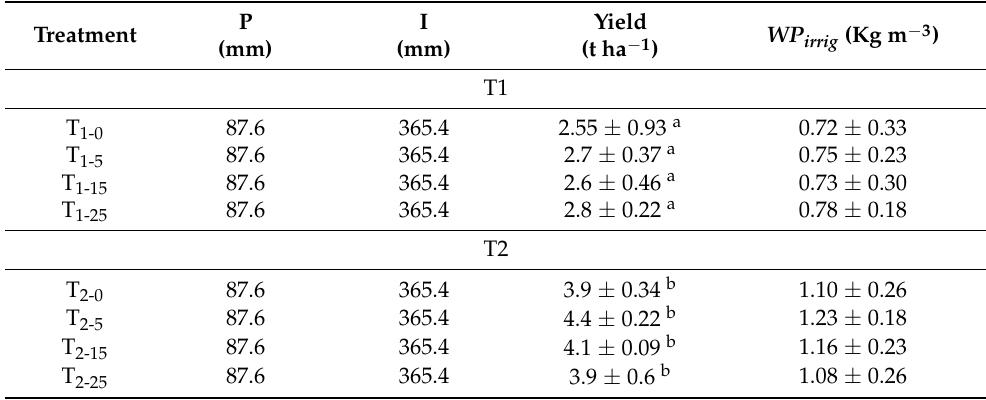
Table 5. Yield and WP irrig of okra crop under different treatments. Treatment